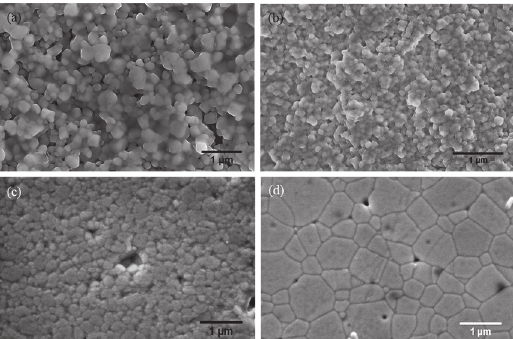
Figure 4: SEM micrographs of the sintered samples: (a) CGd-1200- 1000 °C/10h fracture sintered sample, (b) CGd-0.4Zn-1000-900 °C/5h fracture sintered sample, (c) and (d) polished and thermally etched surfaces of CGd-0.4Zn and CGd-Co samples, respectively, sintered at 1200-1000 °C/10h.